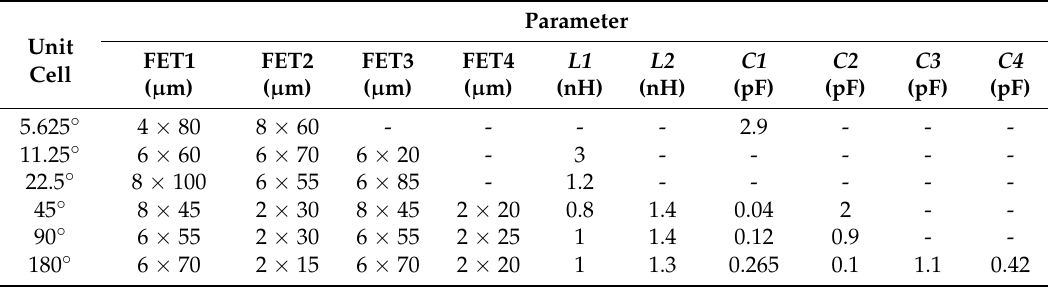
Table 3. The parameters of phase shifter design.